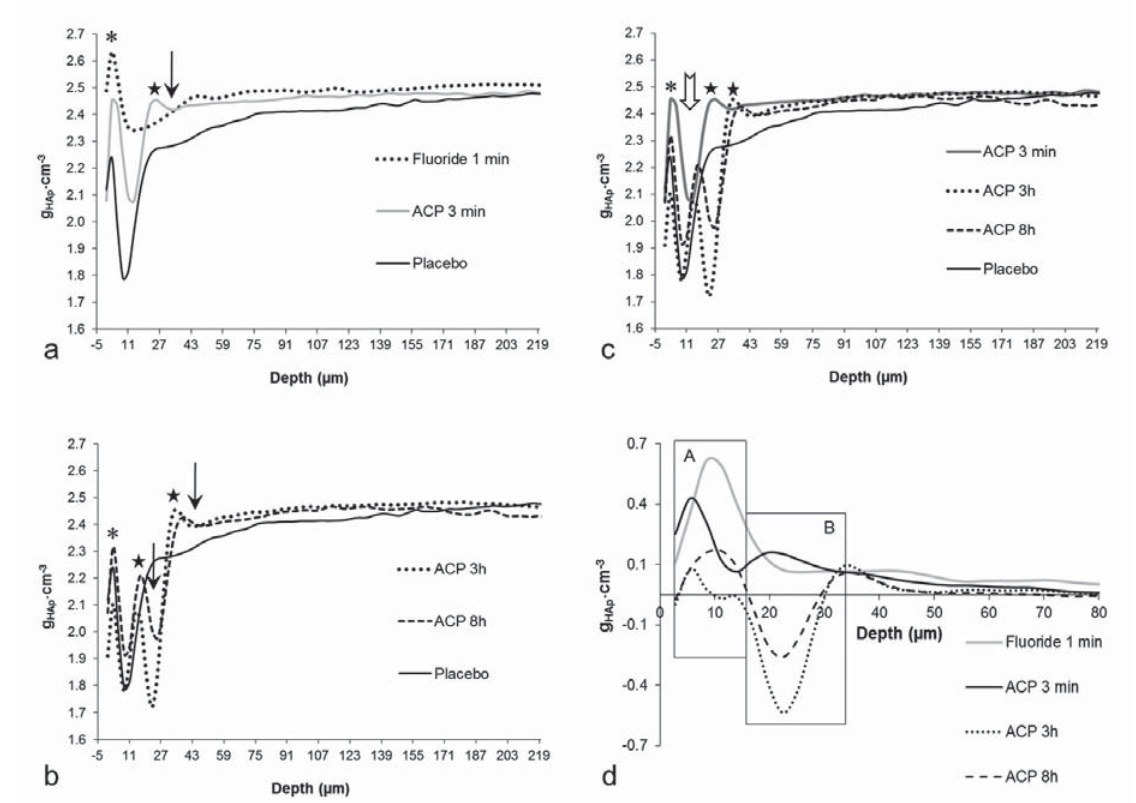
Figure 1- (cid:3)(cid:39)(cid:72)(cid:83)(cid:87)(cid:75)(cid:3)(cid:83)(cid:85)(cid:82)(cid:191)(cid:79)(cid:72)(cid:86)(cid:3)(cid:82)(cid:73)(cid:3)(cid:80)(cid:76)(cid:81)(cid:72)(cid:85)(cid:68)(cid:79)(cid:3)(cid:70)(cid:82)(cid:81)(cid:70)(cid:72)(cid:81)(cid:87)(cid:85)(cid:68)(cid:87)(cid:76)(cid:82)(cid:81)(cid:3)(cid:11)(cid:74) .cm -3 (cid:12)(cid:3)(cid:76)(cid:81)(cid:3)(cid:79)(cid:72)(cid:86)(cid:76)(cid:82)(cid:81)(cid:86)(cid:3)(cid:73)(cid:82)(cid:85)(cid:3)(cid:72)(cid:68)(cid:70)(cid:75)(cid:3)(cid:87)(cid:85)(cid:72)(cid:68)(cid:87)(cid:80)(cid:72)(cid:81)(cid:87)(cid:17)(cid:3)(cid:11)(cid:68)(cid:12)(cid:3)(cid:38)(cid:82)(cid:80)(cid:83)(cid:68)(cid:85)(cid:76)(cid:86)(cid:82)(cid:81)(cid:3)(cid:82)(cid:73)(cid:3)(cid:80)(cid:76)(cid:81)(cid:72)(cid:85)(cid:68)(cid:79)(cid:3)(cid:83)(cid:85)(cid:82)(cid:191)(cid:79)(cid:72)(cid:86)(cid:3)(cid:73)(cid:85)(cid:82)(cid:80)(cid:3)(cid:51)(cid:79)(cid:68)(cid:70)(cid:72)(cid:69)(cid:82)(cid:15)(cid:3) HAp (cid:41)(cid:79)(cid:88)(cid:82)(cid:85)(cid:76)(cid:71)(cid:72)(cid:3)(cid:20)(cid:3)(cid:80)(cid:76)(cid:81)(cid:3)(cid:68)(cid:81)(cid:71)(cid:3)(cid:36)(cid:38)(cid:51)(cid:3)(cid:22)(cid:3)(cid:80)(cid:76)(cid:81)(cid:3)(cid:74)(cid:85)(cid:82)(cid:88)(cid:83)(cid:86)(cid:17)(cid:3)(cid:11)(cid:69)(cid:12)(cid:3)(cid:48)(cid:76)(cid:81)(cid:72)(cid:85)(cid:68)(cid:79)(cid:3)(cid:83)(cid:85)(cid:82)(cid:191)(cid:79)(cid:72)(cid:86)(cid:3)(cid:73)(cid:85)(cid:82)(cid:80)(cid:3)(cid:51)(cid:79)(cid:68)(cid:70)(cid:72)(cid:69)(cid:82)(cid:15)(cid:3)(cid:36)(cid:38)(cid:51)(cid:3)(cid:22)(cid:3)(cid:75)(cid:3)(cid:68)(cid:81)(cid:71)(cid:3)(cid:36)(cid:38)(cid:51)(cid:3)(cid:27)(cid:3)(cid:75)(cid:17)(cid:3)(cid:11)(cid:70)(cid:12)(cid:3)(cid:48)(cid:76)(cid:81)(cid:72)(cid:85)(cid:68)(cid:79)(cid:3)(cid:83)(cid:85)(cid:82)(cid:191)(cid:79)(cid:72)(cid:86)(cid:3)(cid:73)(cid:85)(cid:82)(cid:80)(cid:3)(cid:51)(cid:79)(cid:68)(cid:70)(cid:72)(cid:69)(cid:82)(cid:15)(cid:3)(cid:36)(cid:38)(cid:51)(cid:3) (cid:22)(cid:3)(cid:80)(cid:76)(cid:81)(cid:15)(cid:3)(cid:36)(cid:38)(cid:51)(cid:3)(cid:22)(cid:3)(cid:75)(cid:3)(cid:68)(cid:81)(cid:71)(cid:3)(cid:36)(cid:38)(cid:51)(cid:3)(cid:27)(cid:3)(cid:75)(cid:17)(cid:3)(cid:11)(cid:71)(cid:12)(cid:3)(cid:39)(cid:76)(cid:73)(cid:73)(cid:72)(cid:85)(cid:72)(cid:81)(cid:87)(cid:76)(cid:68)(cid:79)(cid:3)(cid:80)(cid:76)(cid:81)(cid:72)(cid:85)(cid:68)(cid:79)(cid:3)(cid:70)(cid:82)(cid:81)(cid:70)(cid:72)(cid:81)(cid:87)(cid:85)(cid:68)(cid:87)(cid:76)(cid:82)(cid:81)(cid:3)(cid:83)(cid:85)(cid:82)(cid:191)(cid:79)(cid:72)(cid:86)(cid:3)(cid:68)(cid:86)(cid:3)(cid:68)(cid:3)(cid:73)(cid:88)(cid:81)(cid:70)(cid:87)(cid:76)(cid:82)(cid:81)(cid:3)(cid:82)(cid:73)(cid:3)(cid:71)(cid:72)(cid:83)(cid:87)(cid:75)(cid:3)(cid:68)(cid:70)(cid:70)(cid:82)(cid:85)(cid:71)(cid:76)(cid:81)(cid:74)(cid:3)(cid:87)(cid:82)(cid:3)(cid:87)(cid:75)(cid:72)(cid:3)(cid:87)(cid:85)(cid:72)(cid:68)(cid:87)(cid:80)(cid:72)(cid:81)(cid:87)(cid:86)(cid:29)(cid:3)(cid:93)(cid:82)(cid:81)(cid:72)(cid:3)(cid:36)(cid:29)(cid:3) (cid:21)(cid:17)(cid:27)(cid:177)(cid:20)(cid:25)(cid:17)(cid:27)(cid:3)(cid:541)(cid:80)(cid:3)(cid:68)(cid:81)(cid:71)(cid:3)(cid:93)(cid:82)(cid:81)(cid:72)(cid:3)(cid:37)(cid:29)(cid:3)(cid:20)(cid:28)(cid:17)(cid:25)(cid:177)(cid:22)(cid:22)(cid:17)(cid:25)(cid:3)(cid:541)(cid:80)(cid:17)(cid:3)(cid:13)(cid:29)(cid:3)(cid:80)(cid:68)(cid:91)(cid:76)(cid:80)(cid:88)(cid:80)(cid:3)(cid:80)(cid:76)(cid:81)(cid:72)(cid:85)(cid:68)(cid:79)(cid:3)(cid:70)(cid:82)(cid:81)(cid:70)(cid:72)(cid:81)(cid:87)(cid:85)(cid:68)(cid:87)(cid:76)(cid:82)(cid:81)(cid:3)(cid:82)(cid:81)(cid:3)(cid:82)(cid:88)(cid:87)(cid:72)(cid:85)(cid:3)(cid:72)(cid:81)(cid:68)(cid:80)(cid:72)(cid:79)(cid:3)(cid:79)(cid:68)(cid:92)(cid:72)(cid:85)(cid:17)(cid:3) (cid:144) : maximum mineral concentration through the lesion for each group. (cid:216) (cid:29)(cid:3)(cid:86)(cid:88)(cid:69)(cid:86)(cid:88)(cid:85)(cid:73)(cid:68)(cid:70)(cid:72)(cid:3)(cid:79)(cid:72)(cid:86)(cid:76)(cid:82)(cid:81)(cid:17)(cid:3)(cid:315)(cid:29)(cid:3)(cid:79)(cid:68)(cid:80)(cid:76)(cid:81)(cid:68)(cid:87)(cid:76)(cid:82)(cid:81)